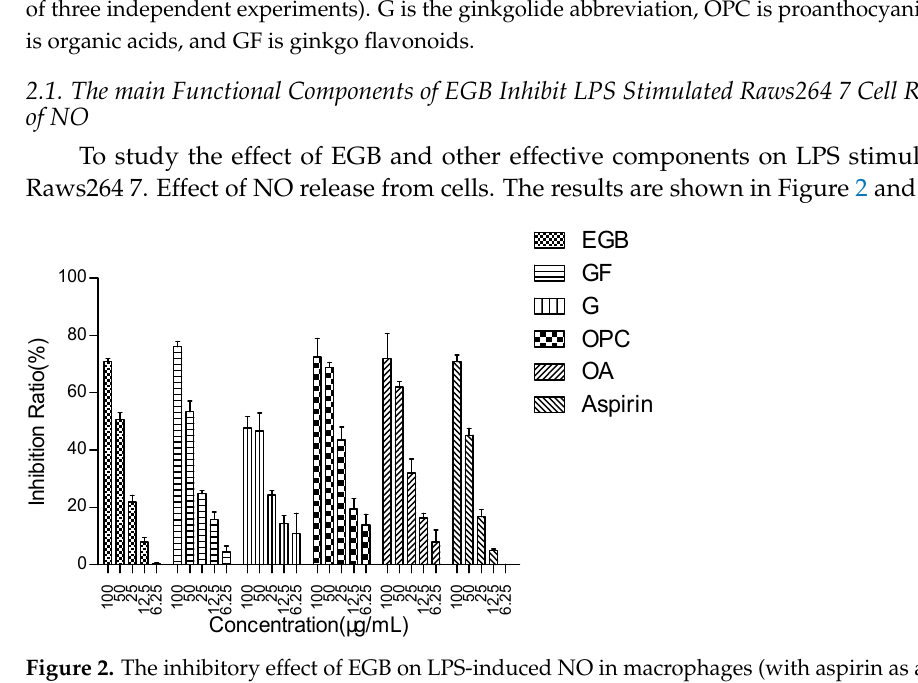
Figure 2. The inhibitory effect of EGB on LPS-induced NO in macrophages (with aspirin as a positive control). All data were averaged ±SD of three independent experiments. Table 1. The IC 50 value of NO in Raws264.7 cells of LPS inhibited by functional components of EGB.